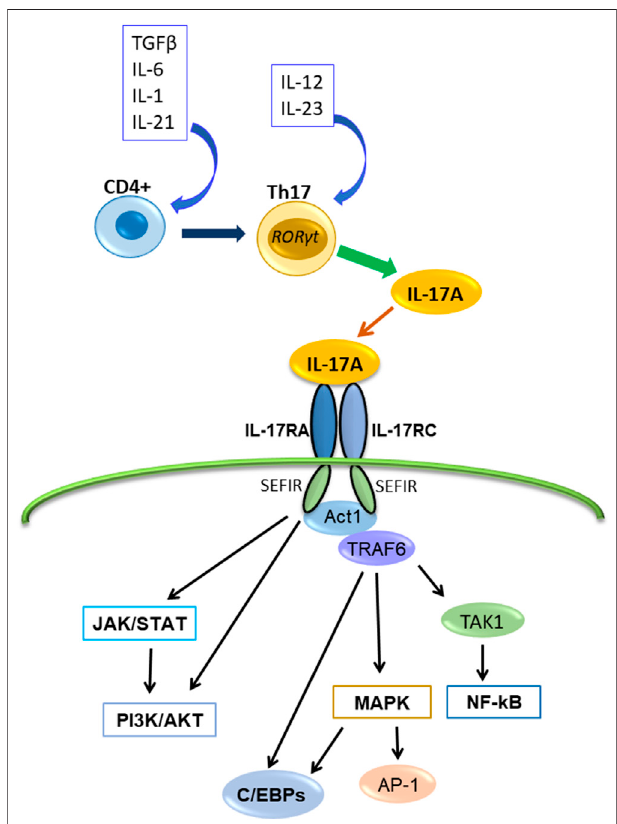
FIGURE 1 | The production of IL-17A, its receptor and transduction signaling pathways. IL-17A is produced by Th17cell and binds the receptor composed of IL-17RA and IL-17RC, and interacts with Act1. Subsequently, Act1 activates multiple independent signaling pathways.